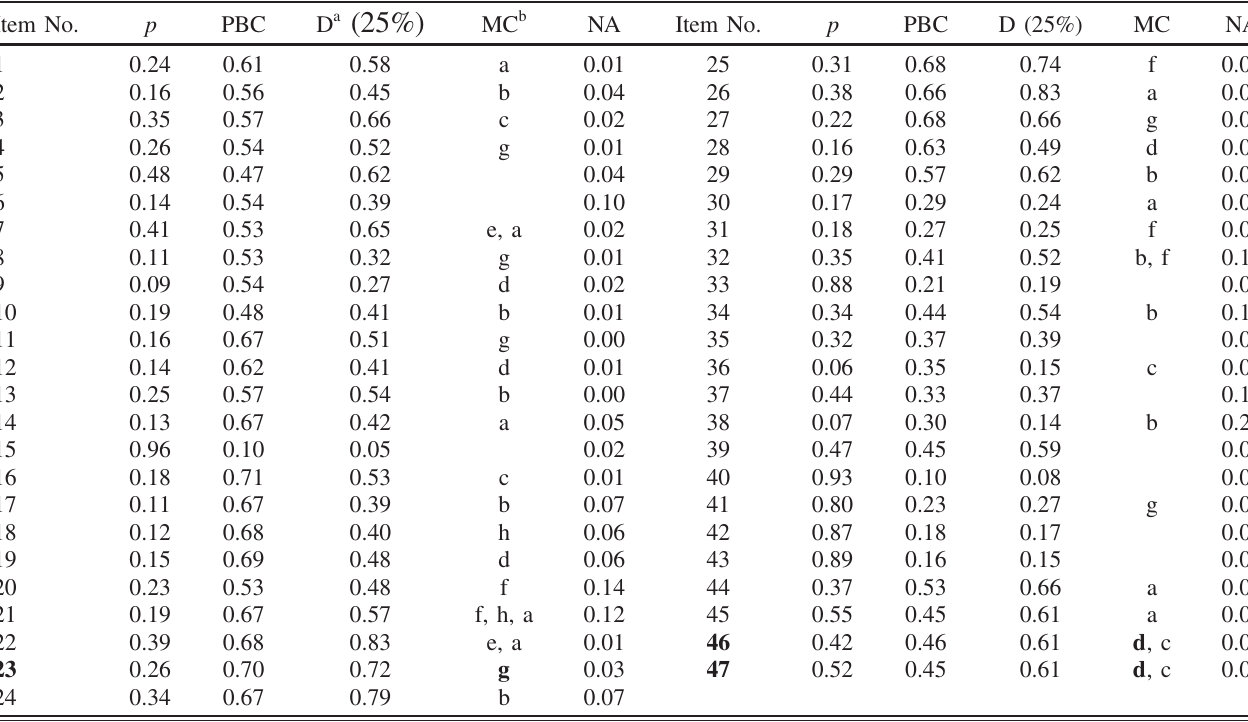
TABLE III. Difficulty index ( p ), point biserial coefficient (PBC), discrimination index (D), and MC of the FMCEJ. Item